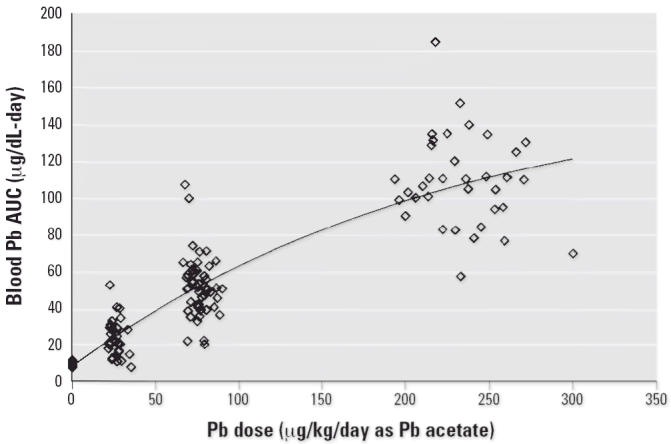
Dose–response curve for blood Pb AUC.